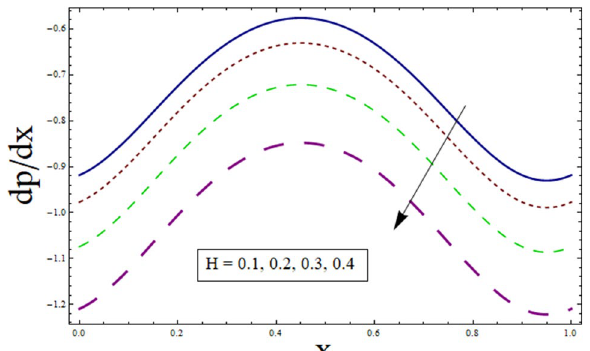
Figure 17. dp/dx for H .